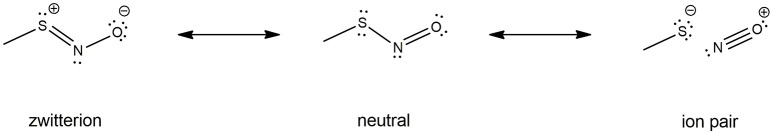
RSNO resonance structures, balanced between the neutral (center), the zwitterion (left) and the ion pair (right) forms. The trans conformer is depicted here, but the cis is also possible though less stable, as mentioned in section Physical Models for S-nitrosothiols (RSNOs). The neutral form is the most abundant one, the other ones being only minor conformations with dramatically opposite features—hence the dual reactivity of RSNOs with nucleophiles. The relative abundance of the three RSNO forms is highly depend on its microenvironment and the nature of the R group. For instance, the neutral/zwitterion/ion pair ratio is 79/11/10% vs. 75/15/10% for HSNO and CH3SNO respectively.